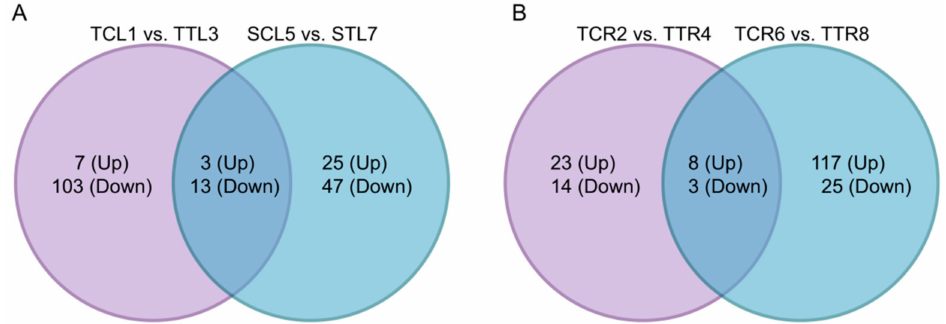
Figure 6. Venn diagram of unique DGEs in each genotype. ( A ): Unique DEGs in leaves. ( B ): Unique DEGs in roots. The absolute value of log2 fold change was equal to or greater than